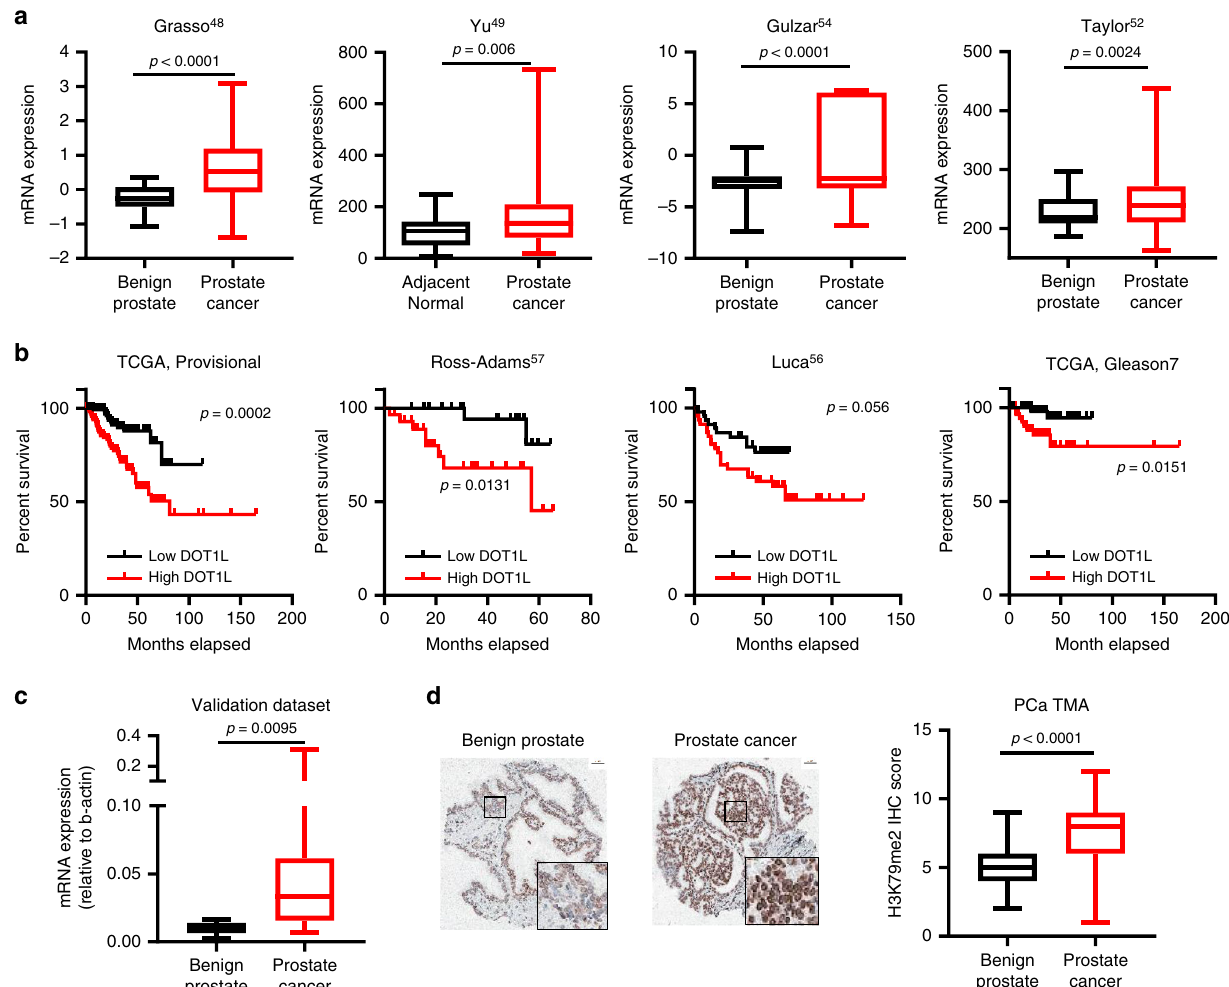
Fig. 1 DOT1L expression is upregulated in prostate cancers and high expression correlates with poor disease-free survival. a Comparison of DOT1L expression in four cohorts of prostate cancer patients ’ datasets. Data for this analysis were used from the Grasso PCa dataset [benign ( n = 28), PCa ( n = 94)], Yu PCa dataset [normal ( n = 60), PCa ( n = 81)], Gulzar Prostate cancer dataset [normal ( n = 66), prostate cancers ( n = 83) and Taylor PCa dataset [normal (n = 29), PCa ( n = 150)]. b Disease-free Survival analysis of three independent cohorts of prostate cancer patients divided by expression of DOT1L using 25 percentile and 75 percentile cutoffs. Data was used from the Luca CancerMap prostate cancer dataset [ n = 46 per group], TCGA prostate cancer dataset [ n = 122 per group], Ross-Adams Discovery dataset [ n = 27 per group] and TCGA Gleason 7 patients [ n = 61 per group]. c Comparison of DOT1L expression in an independent dataset with PCa patient specimens [benign ( n = 15), PCa ( n = 45)]. d Representative images (left) and comparison of average H3K79me2 staining scores in tissue sections from a PCa TMA [normal ( n = 80), PCa ( n = 80)] Scale bar indicates 50 μ M. Statistical tests: p value determined by two-sided Welsh ’ s t test ( a , c , d ) and Log-rank test. For box plots, minima and maxima values are shown ( a , c , d H3K79me2 marked genic regions versus intergenic regions in both cell lines and found that while the H3K79me2 genic regions were equally affected in LNCaP cells and PC3 cells, the intergenic regions were speci fi cally sensitive to EPZ depletion in the LNCaP cells (Supplementary Fig. 2k).